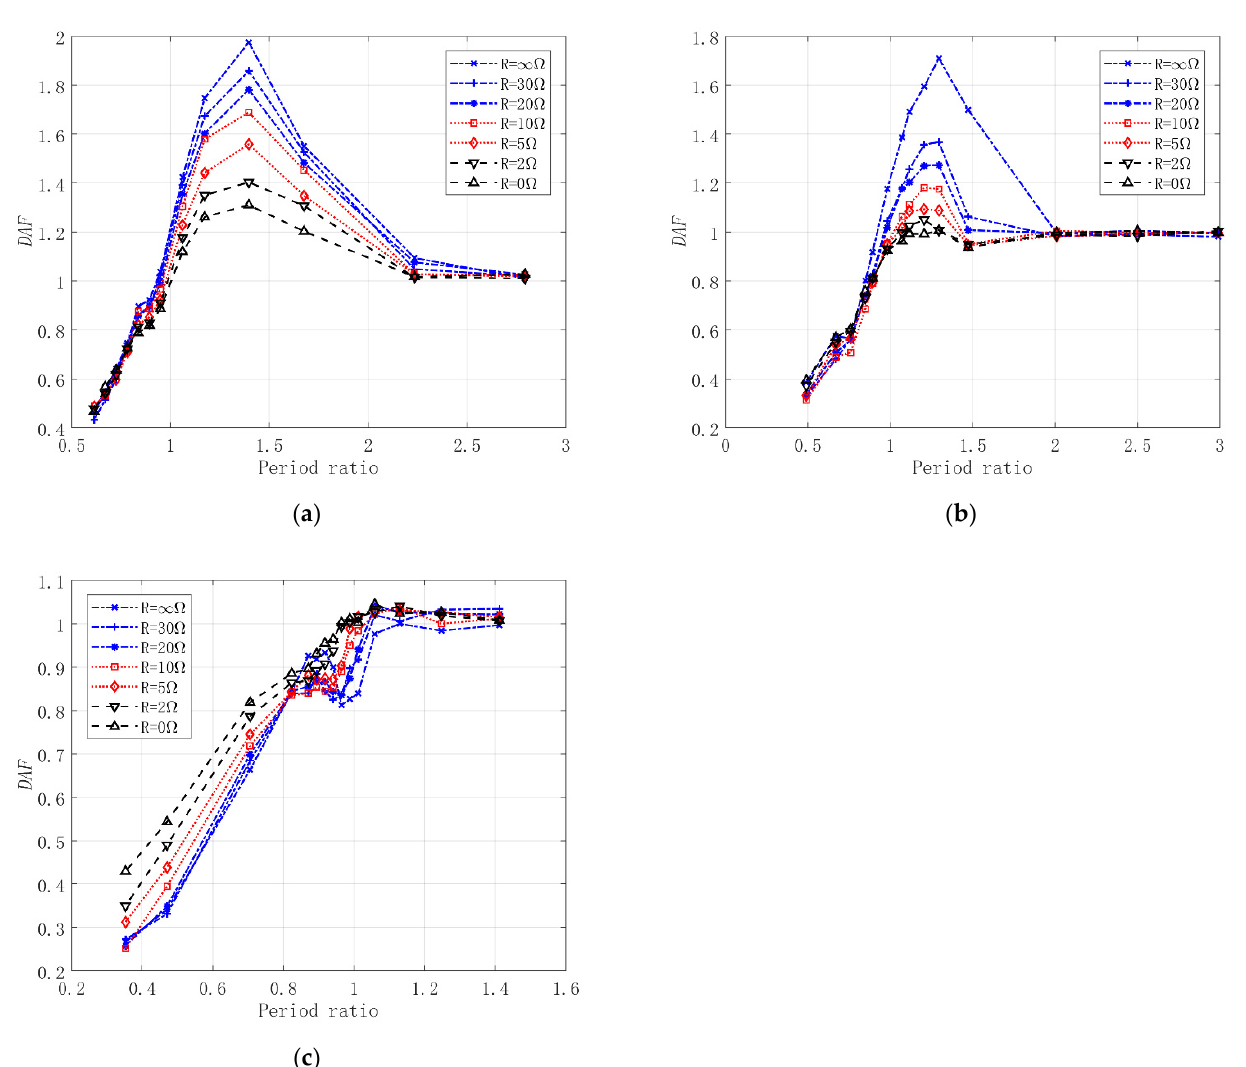
Figure 13. The dynamic amplification factor (DAF) values of the tuned heave plate system with different tuned periods and load resistance. ( a ) THP1; ( b ) THP2; ( c ) THP3.